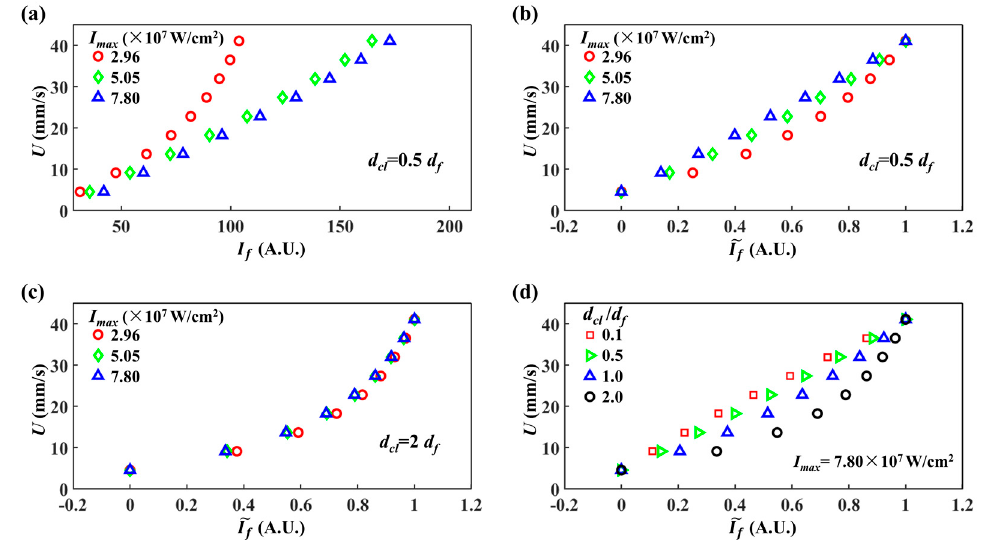
Figure 8. LIFPA velocity calibration curves. ( a ) Original calibration curves for different laser power densities at d cl = 0.5 d f ; ( b ) normalized calibration curves for ( a ); ( c ) normalized calibration curves for different power densities at d cl = 2 d f ; ( d ) normalized calibration curves for different d cl at I max = 7.80 × 10 7 W/cm 2